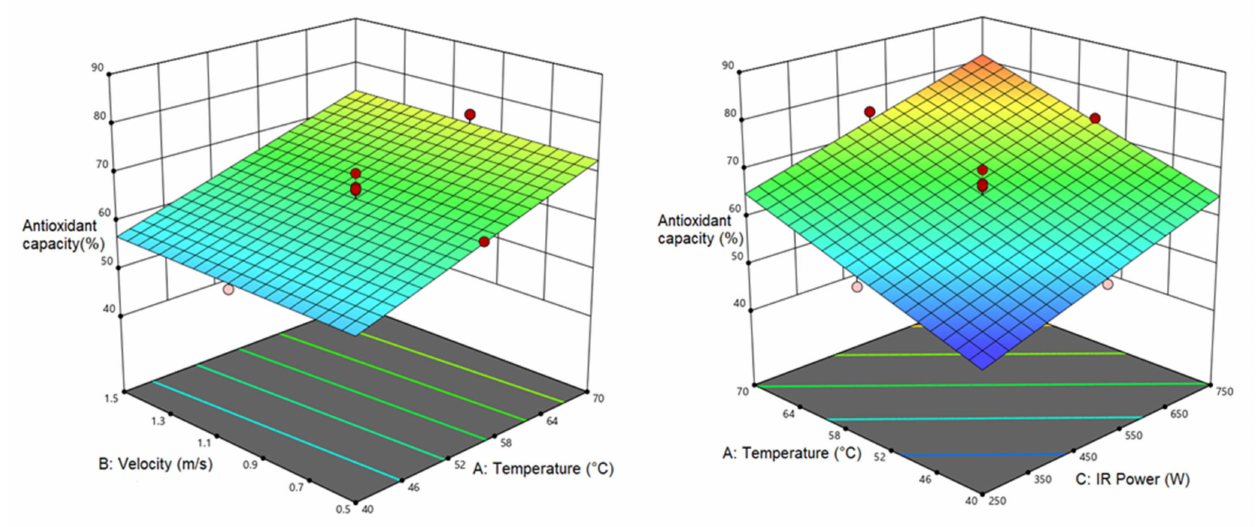
Figure 7. Interaction of air temperature/air velocity and air temperature/IR power on AA of pumpkin.